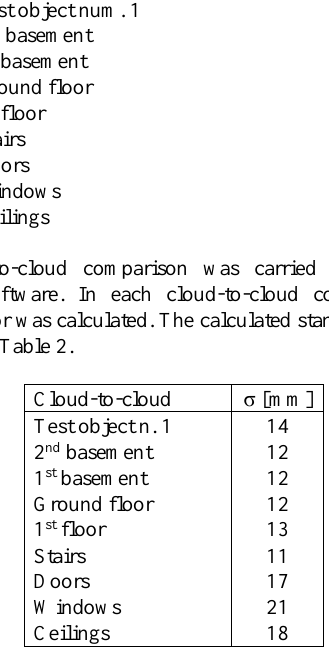
Table 2 . Calculated standard errors of cloud-to-cloud comparison between point cloud from Leica BLK360 and Leica BLK2GO.